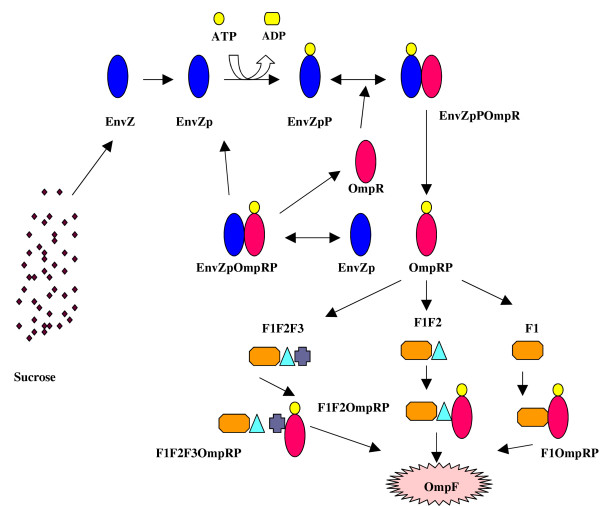
Molecular Model of Osmoregulatory switch operative at Low Osmolarity in Escherichia coli. The low osmolarity conditions favour the phosphatase activity of EnvZ. The Phosphatase domain (EnvZp) upon autophosphorylation leads to formation of EnvZppOmpR complex and later favours the dephosphorylation of the cellular OmpRP thus making OmpRP available only for cooperative binding to the high affinity promoter of OmpF namely F1, F1F2, and F1F2F3 favouring OmpF expression.